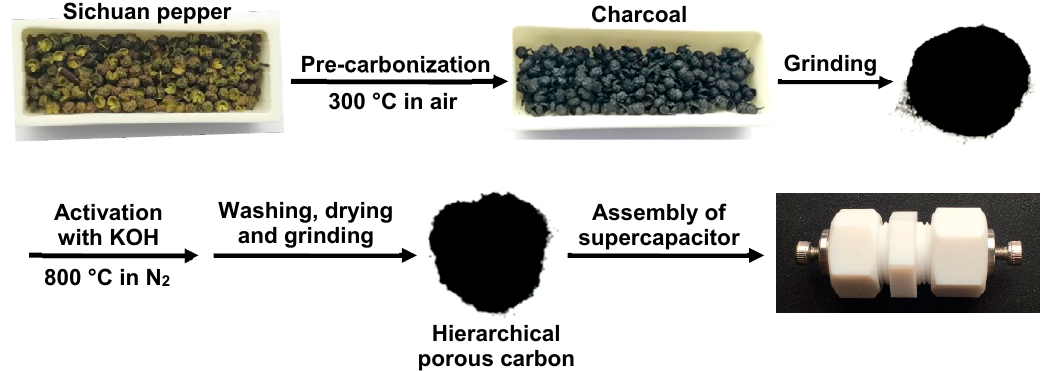
Figure 1. Schematic representation of the preparation of hierarchical porous biomass carbon derived from Sichuan pepper.